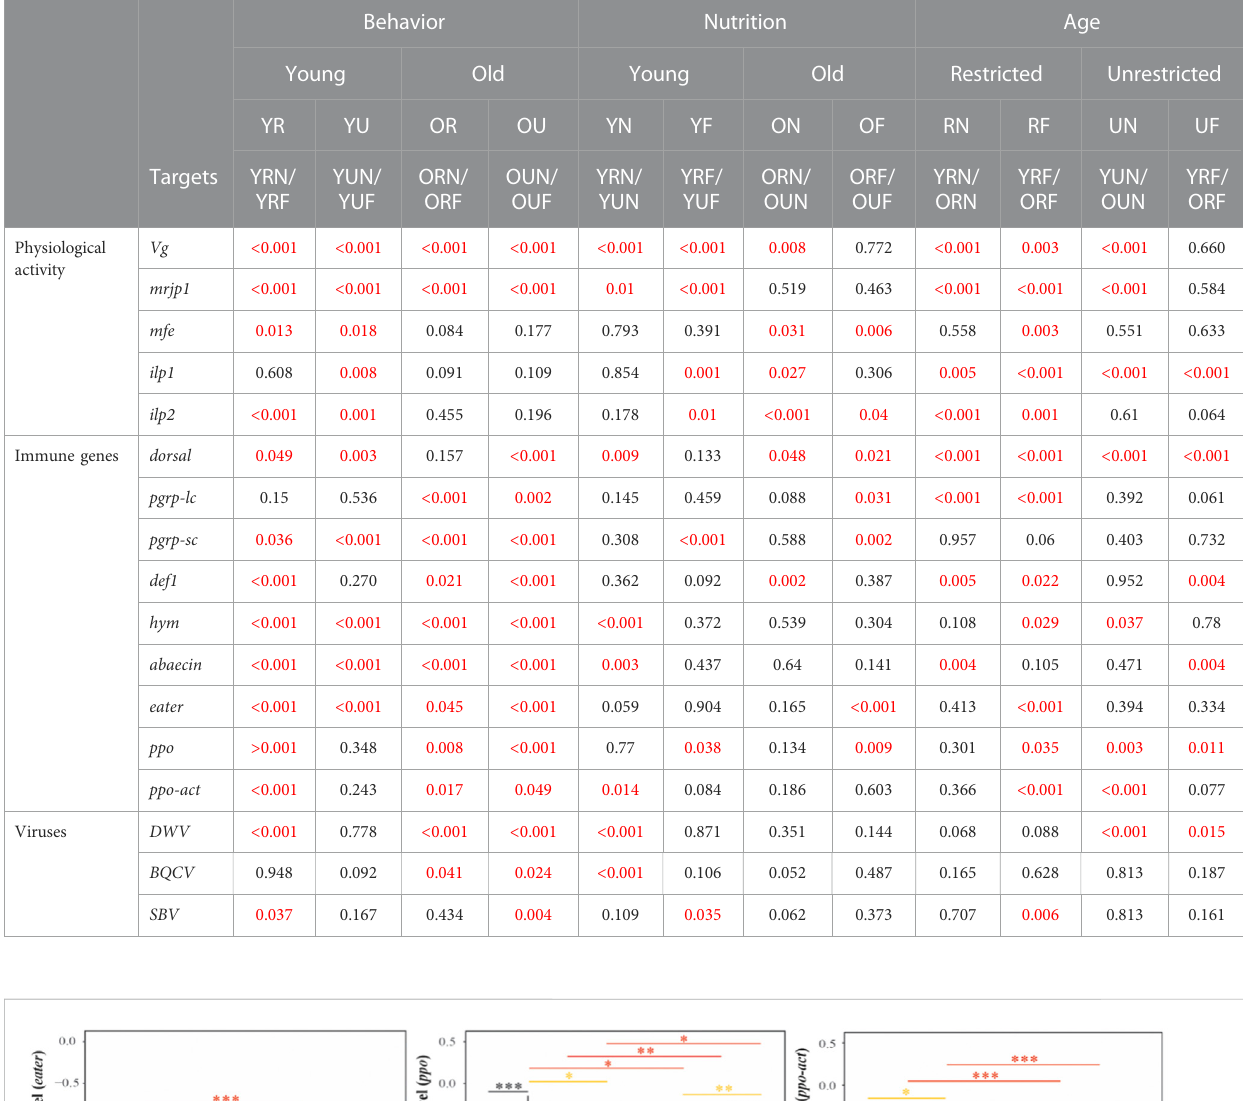
TABLE 2 Probability values of paired comparisons of behavioral, age, and nutritional groups on gene expression and viral titers. All the targets were analyzed using the Mann-Whitney test. Signi fi cant p-values are indicated in red case.